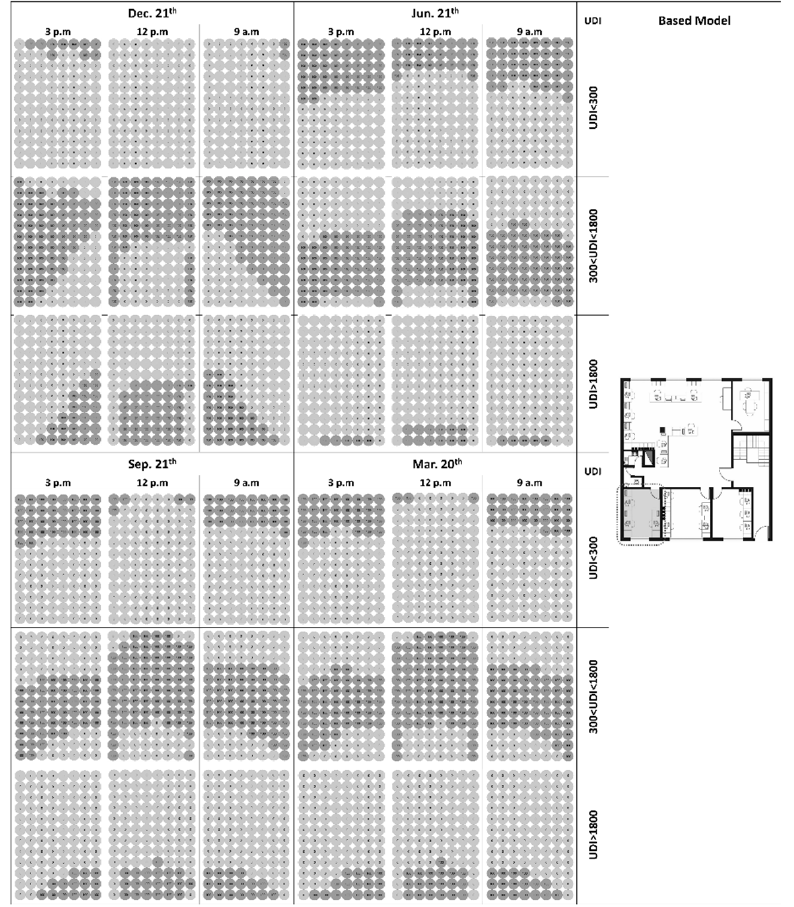
Figure 10. Useful Daylight Illuminance of critical days in the base model.